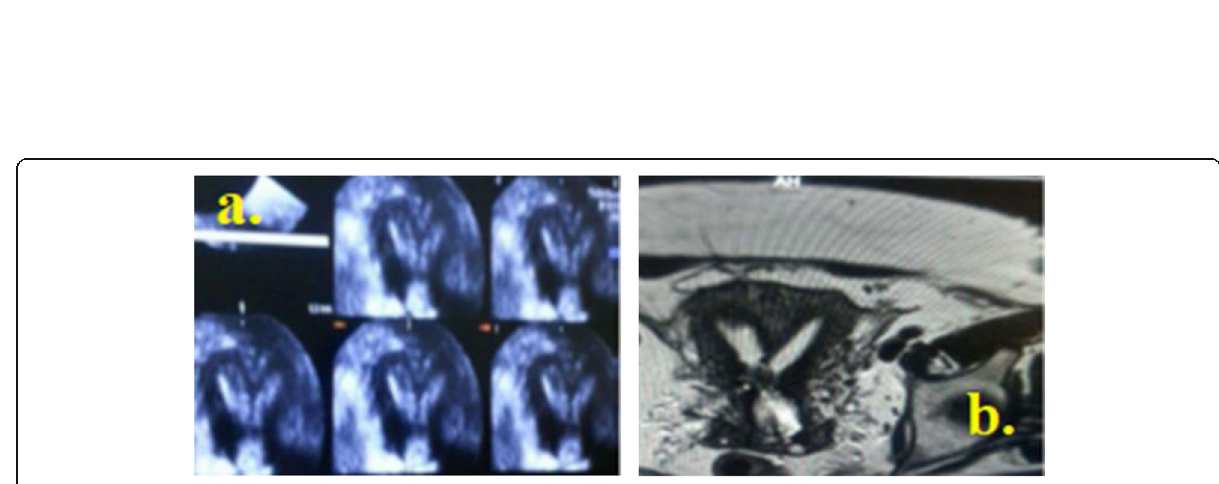
Fig. 10 A 40-year-old married female patient complaining of recurrent abortion. a Partial bicorporeal uterus (class U3a) diagnosed by 3DTVS showing external fundal indentation partially dividing cavity. b MRI coronal oblique T2 revealed straight fundal outline with septum partial dividing uterine cavity, diagnosed as partial septate uterus (class